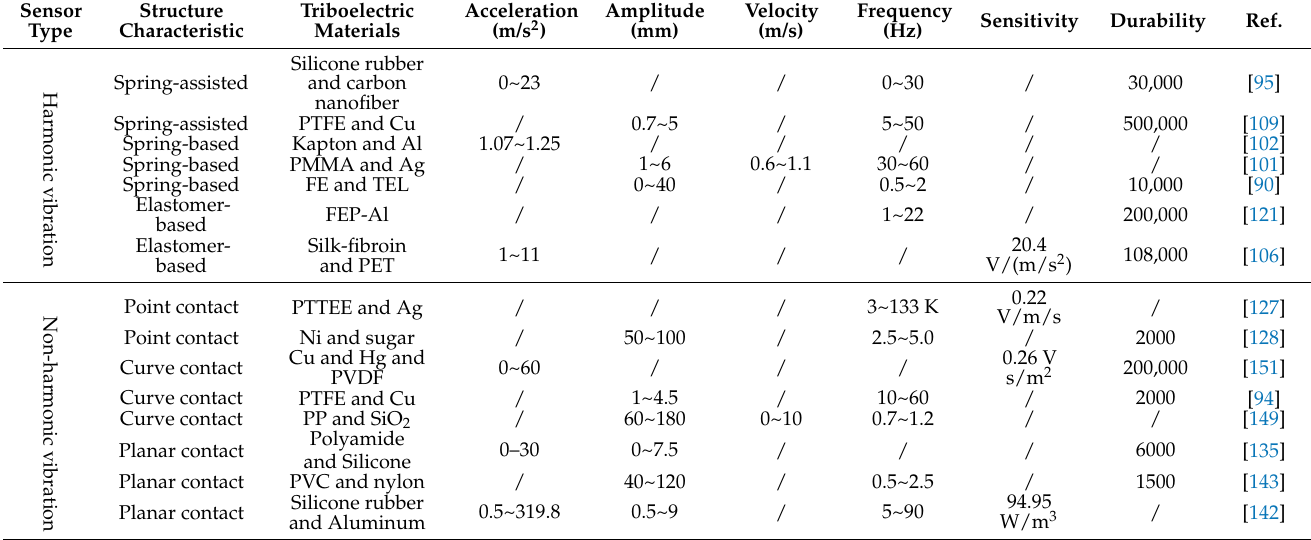
Table 1. A summary of structure characteristic and sensing property of various TENG-based vibration